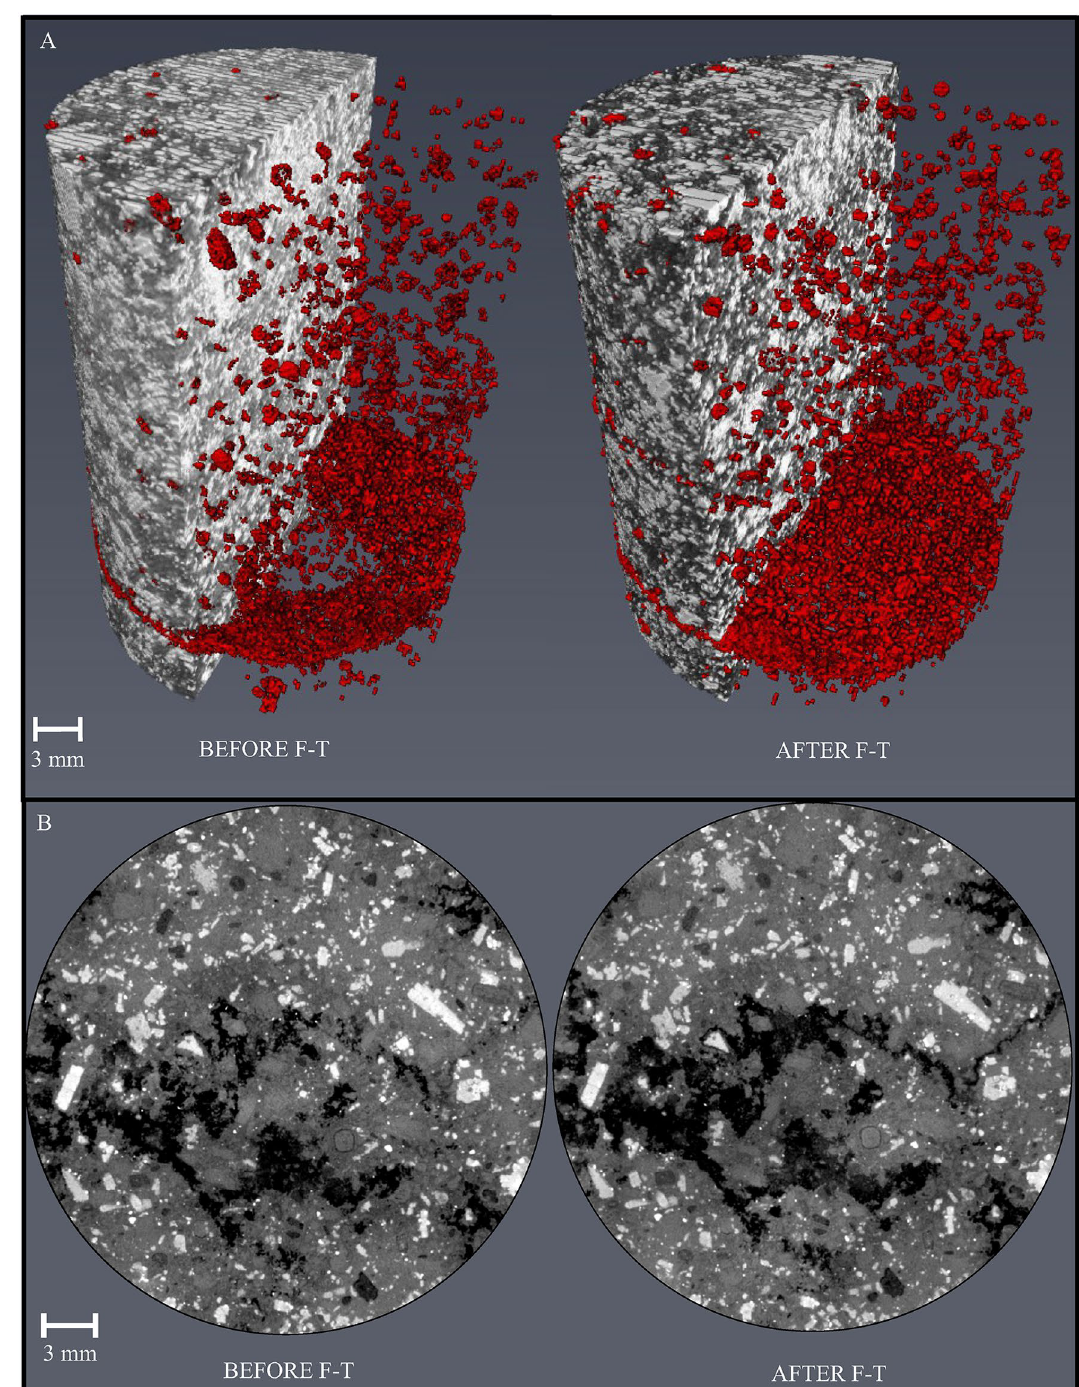
Figure 6. ( A ) Distribution of voids before and after 100 F–T cycles by X-ray µtomography showing changes in porosity as an expression of F–T decay; ( B ) Fracture on 2D orthoslices before and after 100 F–T